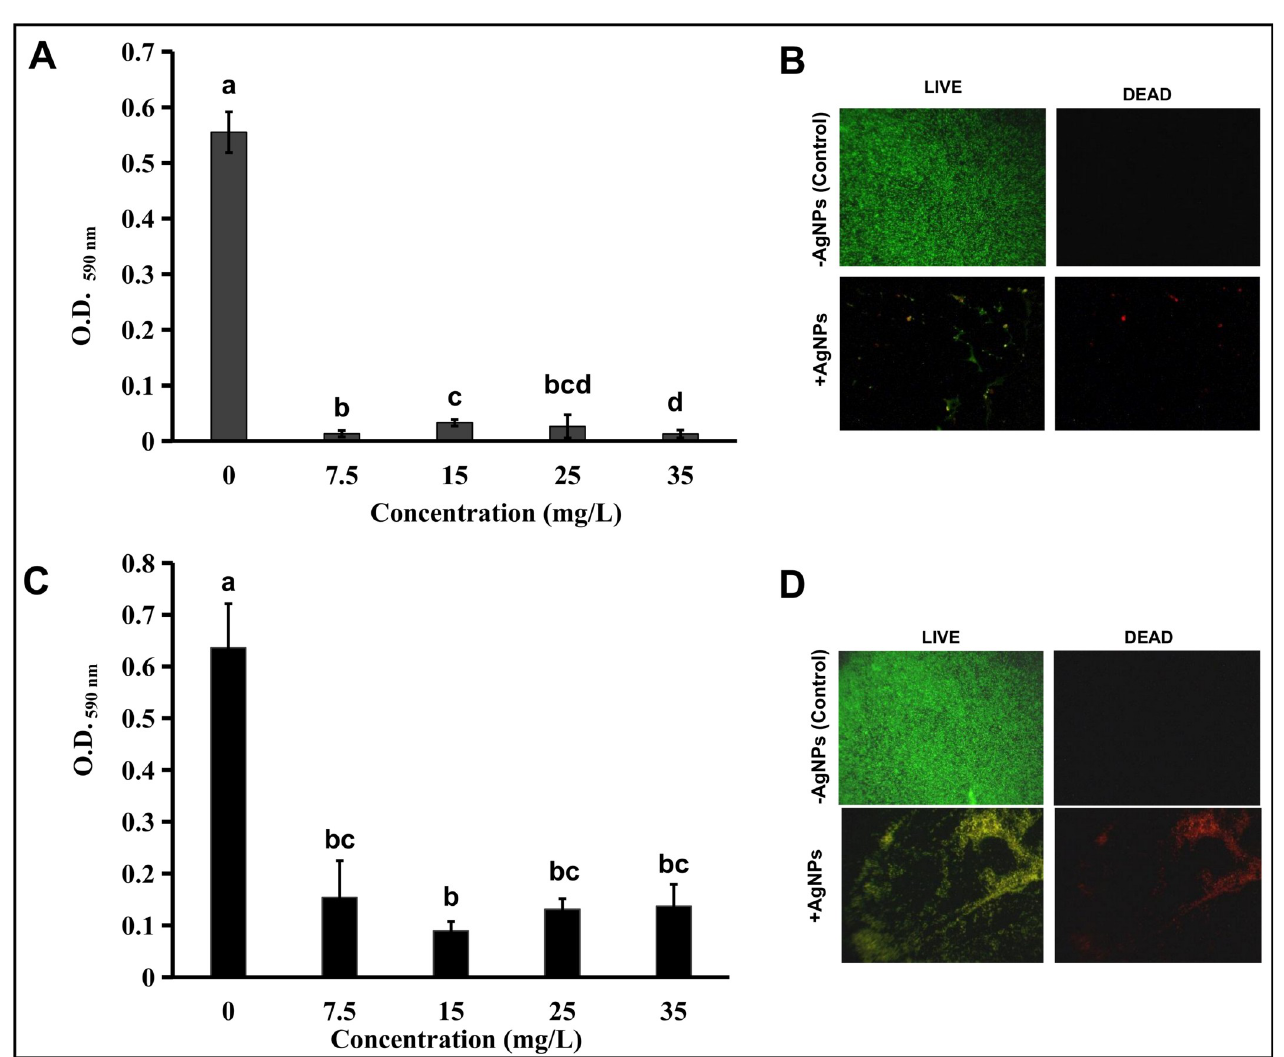
Fig 10. Effect of fungal biosynthesized AgNPs over biofilm formation and preformed biofilms of uropathogenic Escherichia coli (UPEC). (A) Inhibition of biofilm formation of cell suspensions treated with different AgNPs concentrations and determined by measurement of crystal violet dye attached to biofilm- associated cells at OD 590 nm . (B) Damage produced over established biofilms treated with different AgNPs concentration and determined by measurement of crystal violet dye attached to biofilm-associated cells at OD 590 nm . (C and D) Micrographs of UPEC-PAM5 strain treated with 7.5 mg/L AgNPs (+AgNPs) or without AgNPs (-AgNPs) before the biofilm formation (C) and in preformed biofilms (D). Bacterial cells were stained with Live/Dead BacLight Viability kit and observed by fluorescence microscopy at 40X amplification. Each bar in graphs (A and C) represents the mean of data collected from three independent experiments done in triplicate, and the error bars represent standard errors of the means (SEM). The statistical differences (a, b, c, and d) between the biofilm formation at the different AgNPs concentration tested, as determined by t-test ( P < 0.05), are shown above each bar.